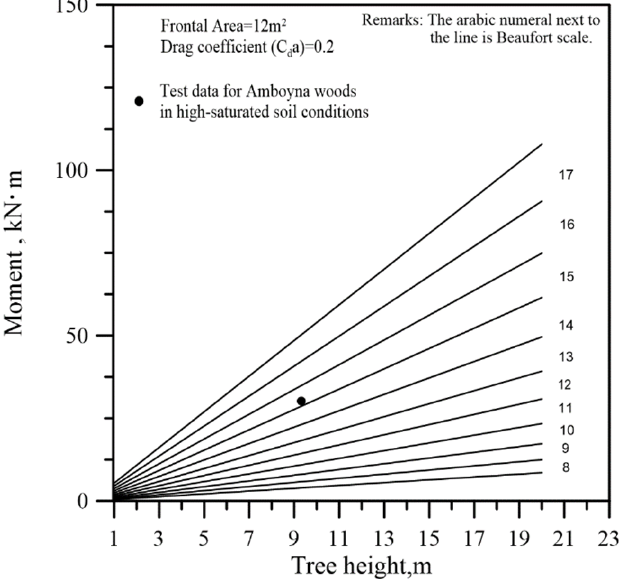
Figure 8. The relationship between the Beaufort scale and the turning moment, applied to trees with a canopy frontal area of 12 m 2 . a canopy frontal area of 12 m 2